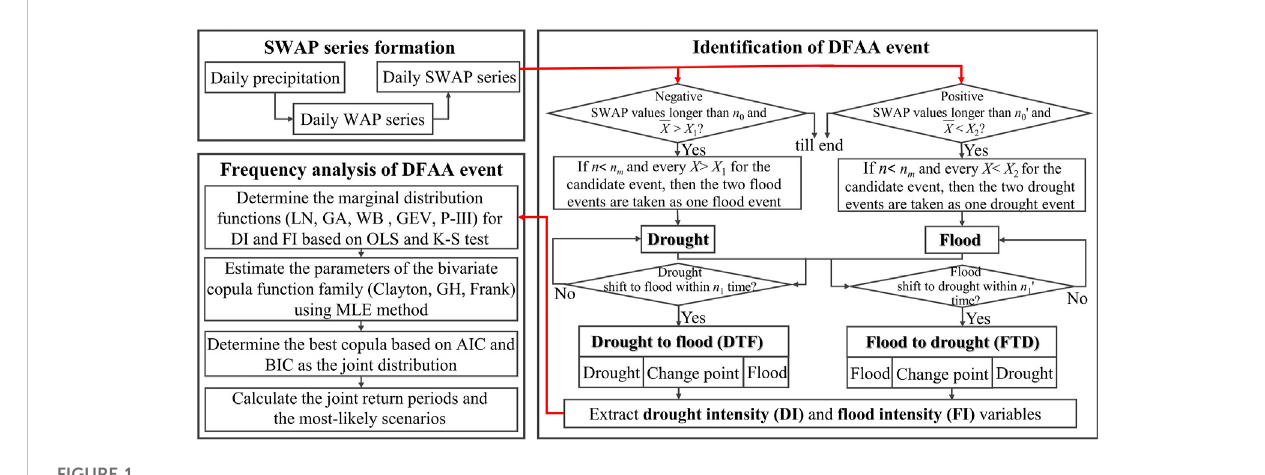
FIGURE 1 Flowchart of the identi fi cation and frequency analysis of the DFAA